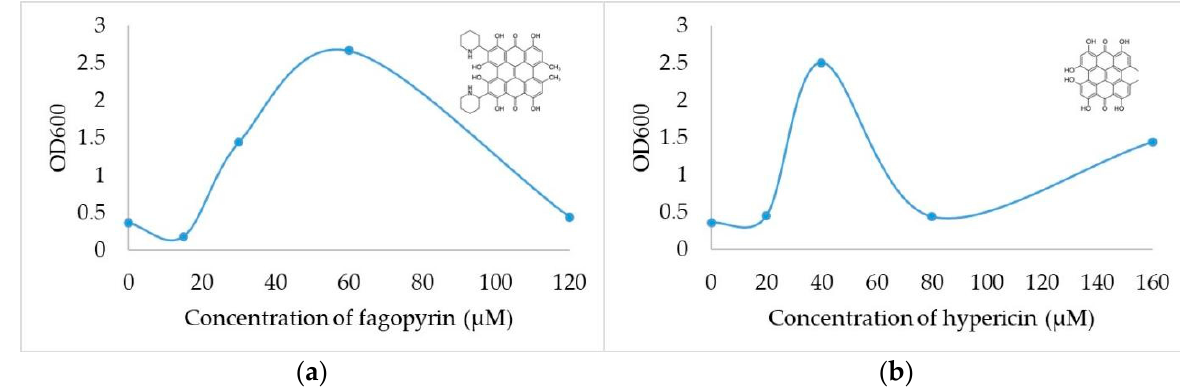
Figure 1. Representative dose–response curves of photosensitizers on yeast growth. Cultures in suspensions with identical initial density (OD600) were allowed to grow for 3 h (doubling time 1.5 h) after addition of photosensitizers: ( a ) Effect of fagopyrin (C40H34N2O8); ( b ) Effect of hypericin (C30H16O8). Of note, the similarity and the differences of the two structures: both compounds contain a naphthodianthrone skeleton, but fagopyrin has two piperidines, which are not present in hypericin